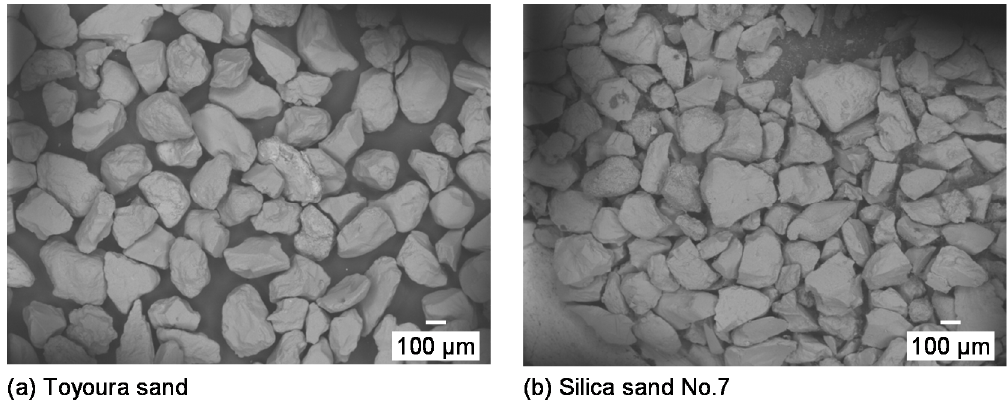
Figure 1. Field emission scanning electron microscopy (FE-SEM) image of the microstructure of ( a ) Toyoura sand and ( b ) Silica sand No. 7 used in the experiments.